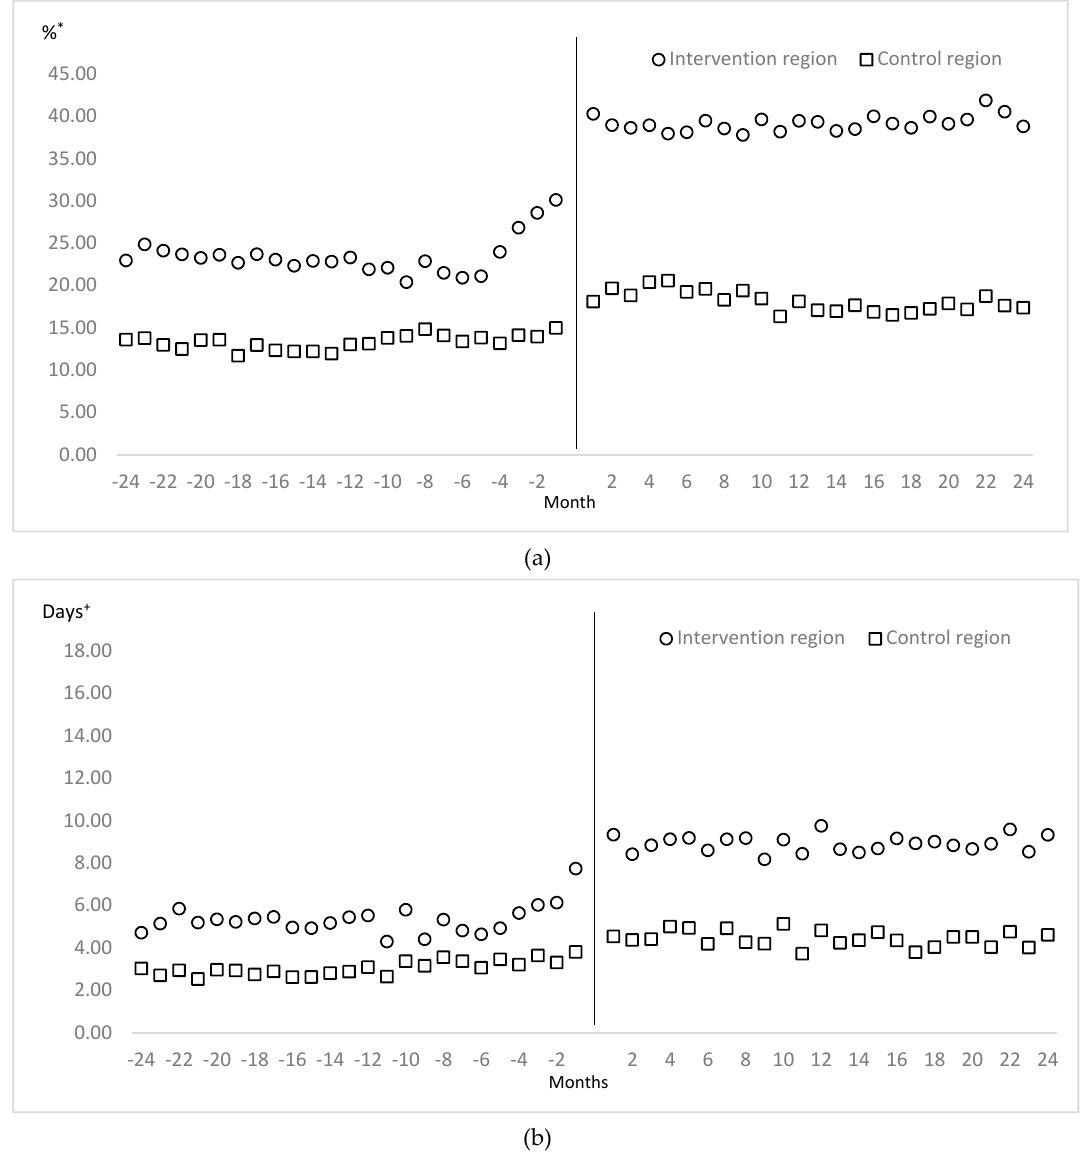
Figure 2. Comparison of dispensation per prescription ( a ) and dispensation days per patient with hypertension ( b ) on pre-intervention and post-intervention between study regions. * Proportion of dispensation per prescription on hypertensive patients during given period. + Dispensed days per patient with hypertension during given